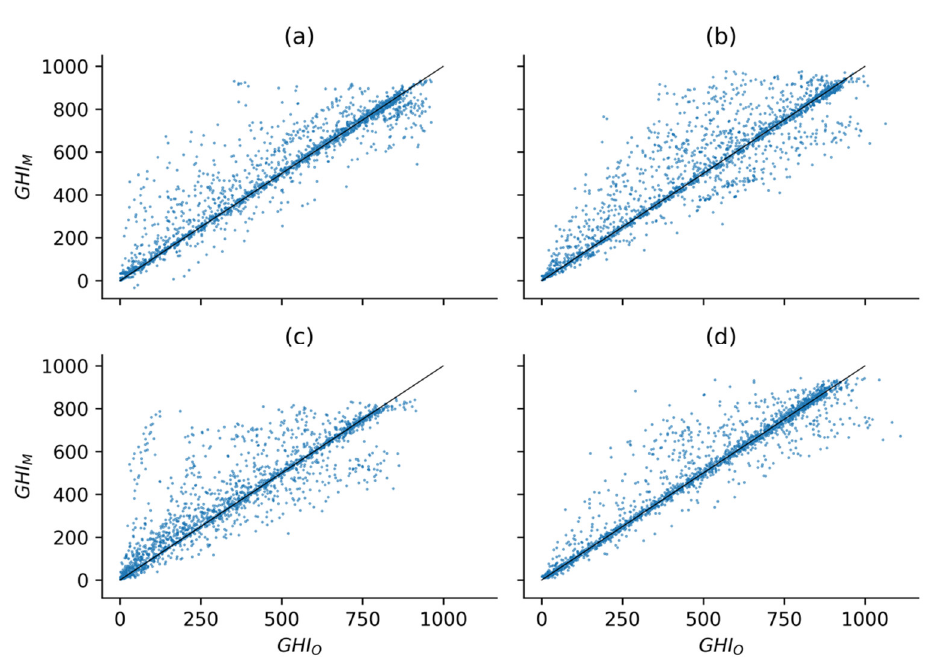
Table 3. Coefficients relating cloud index to clear sky index.